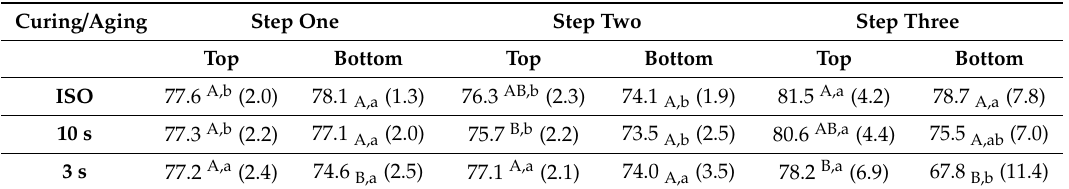
Table 5. Depth-sensing indentation test: mean Vickers’ hardness HV in N / mm 2 (mean and standard deviation). Superscript / subscript letters indicate homogeneous groups; Capital letters indicate sub-groups related to columns; Lowercase letters indicate sub-groups related to rows; Tukey’s post-hoc test ( α = 0.05).